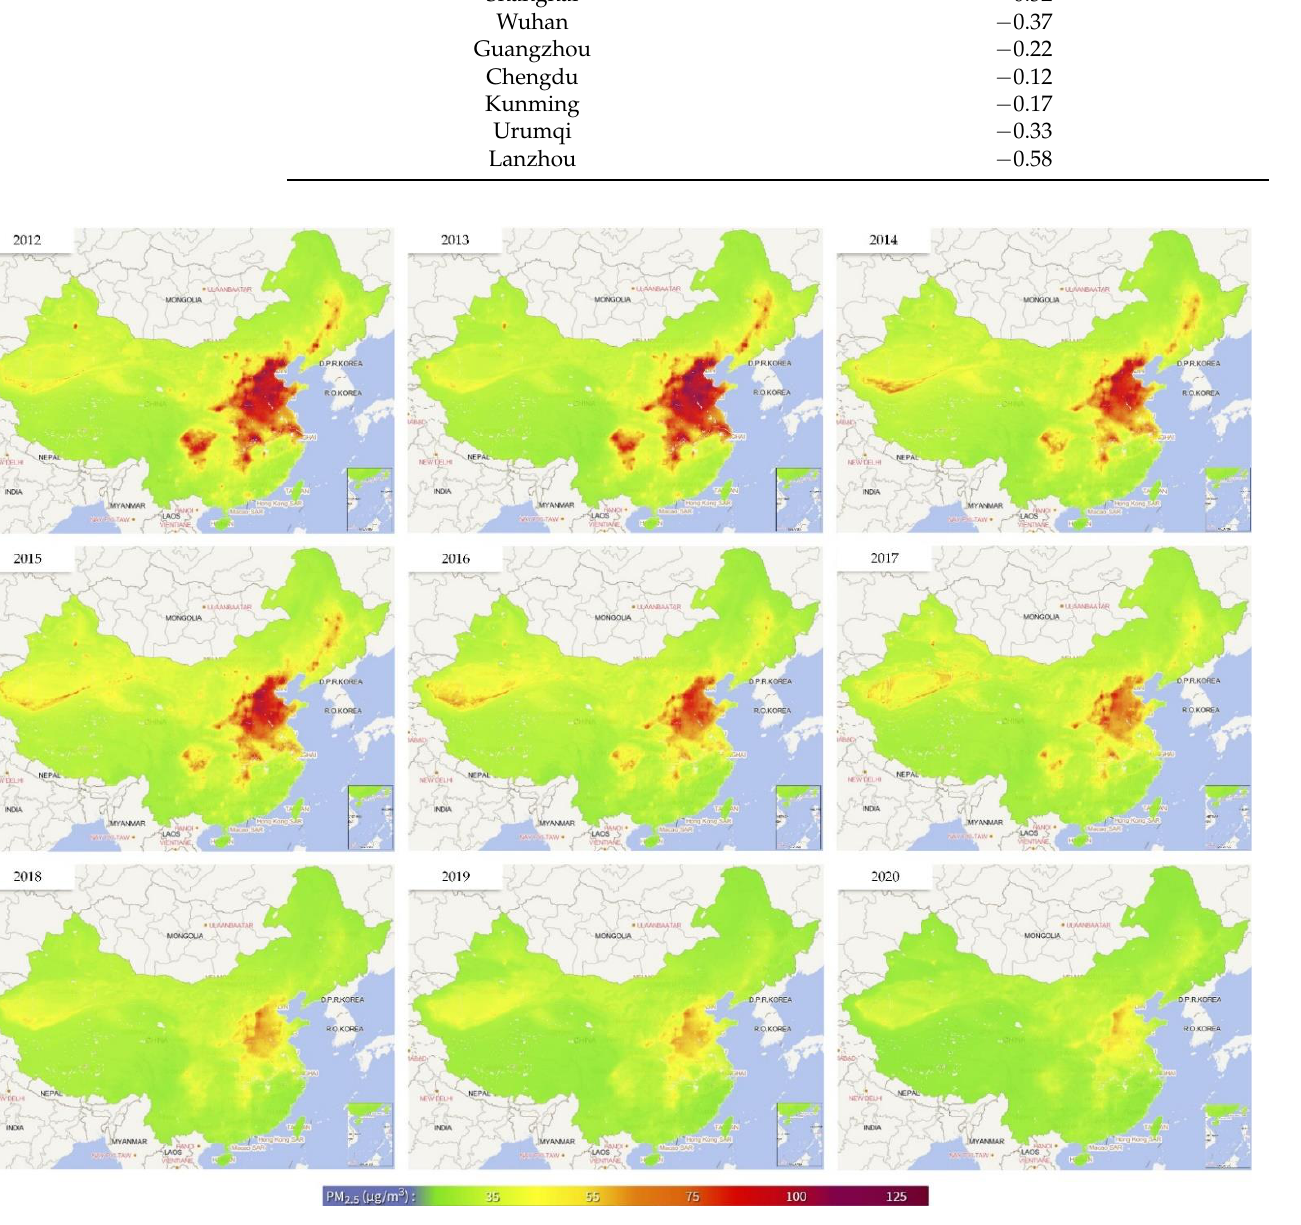
Figure 6. The spatial distributions of annual PM2.5 concentrations from 2012 to 2020 (Source: http://tapdata.org.cn, accessed on 11 May 2022).